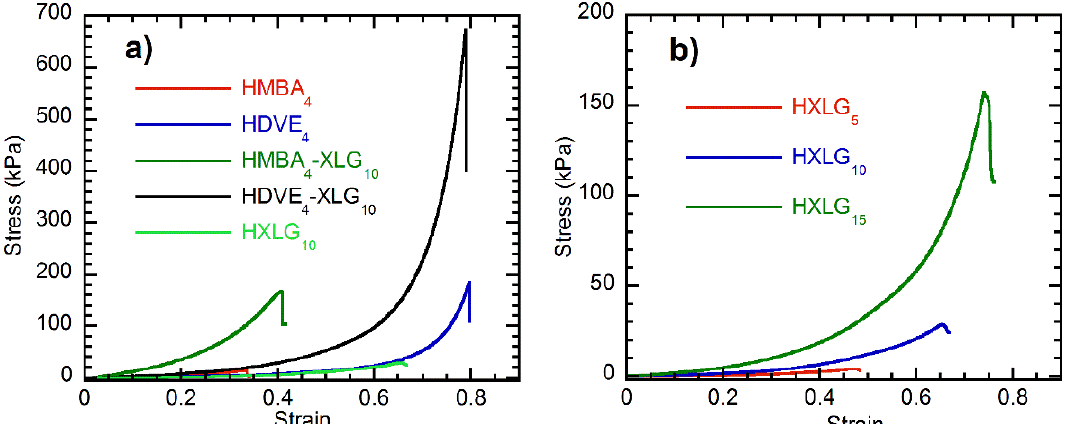
Figure 11. Typical stress–strain curves for the hydrogels synthesized: ( a ) the effect of crosslinker type; ( b ) the effect of XLG concentration.